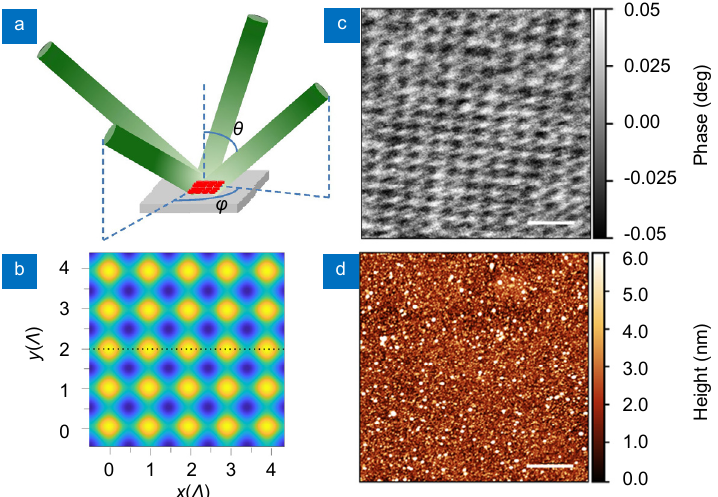
Fig. 1 | ( a ) Schematic of the DLIP geometry with four laser beams that impinge on the sample surface and their superposition provides the inter- ference pattern. ( b ) Laser intensity distribution simulated for all the beams of TE polarization and equal intensity, which incident at the same angle  , while the azimuthal angles are  i =  ( i -1)/2, where i =1, 2, 3, 4. Under such parameters, the lattice periodicity is given by Λ =  /(2sin θ ) 33 . In our experiments, Λ was varied between 0.4 and 2.3 µm. ( c ) MFM image of a Fe 60 Al 40 35 nm thick sample treated by DLIP with Λ =0.4  m and ( d ) corresponding